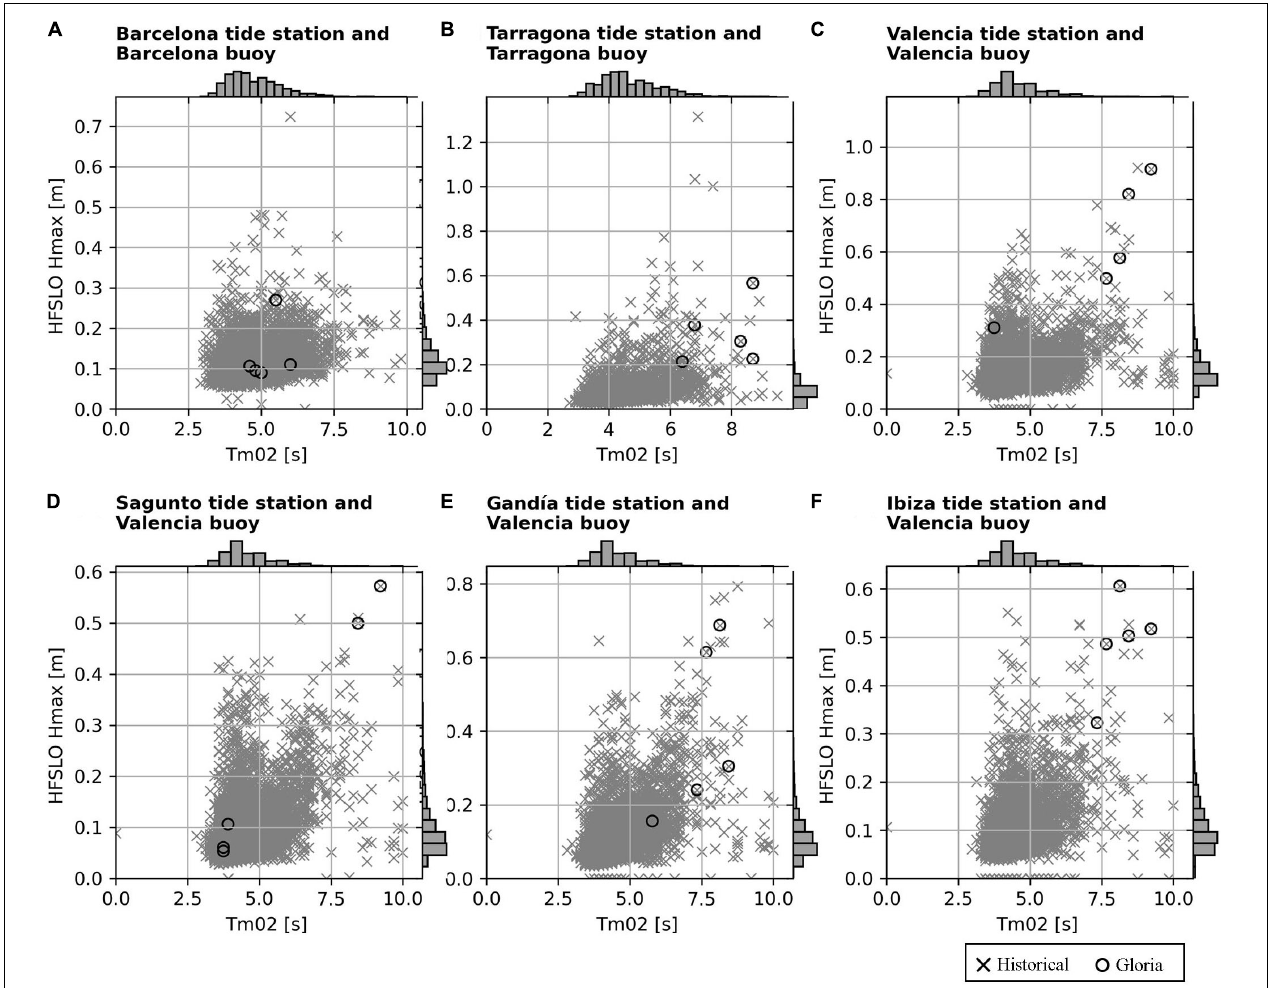
FIGURE 8 | HFSLO H max (30 s-1 h) at tide gauges, vs T m 02 at the closest buoy, for the historical tide gauges record at Barcelona (A) , Tarragona (B) , Valencia (C) , Sagunto (D) , Gandía (E) , and Ibiza (F) . Black circles correspond to storm Gloria. For some of the stations (Valencia, Sagunto and Ibiza), the maximum value of H max was recorded during Gloria. At other stations (Tarragona) the maximum value does not correspond to this